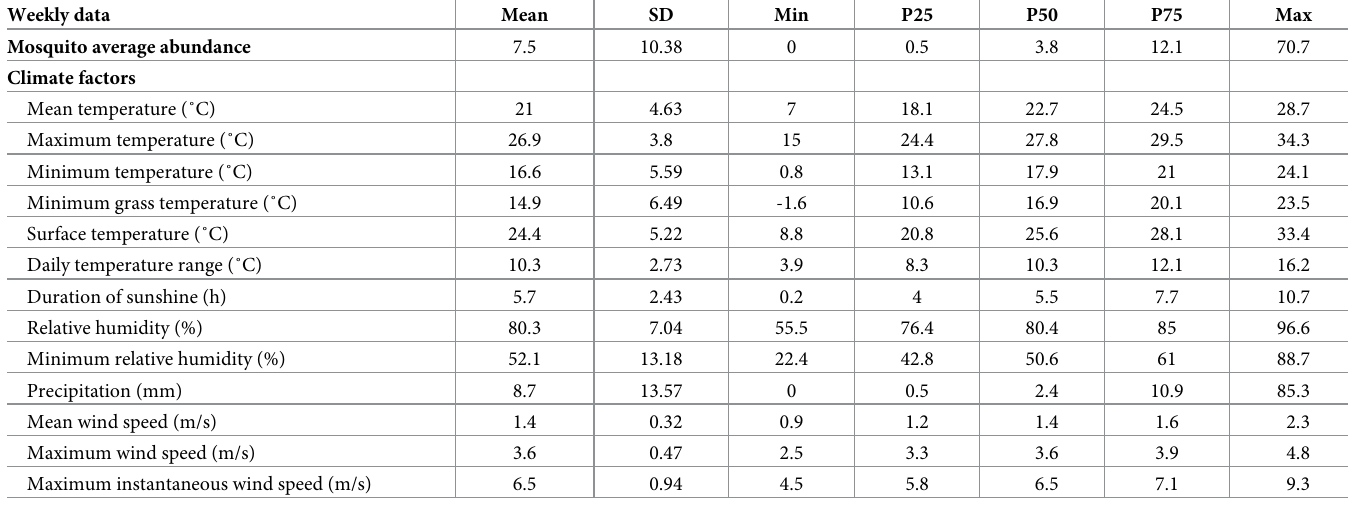
Table 2. Distribution of weekly data on Anopheles sinensis average abundance and climate factors in Goyang, Korea, during the period from 23 to 43 weeks in 2008–2012. Weekly